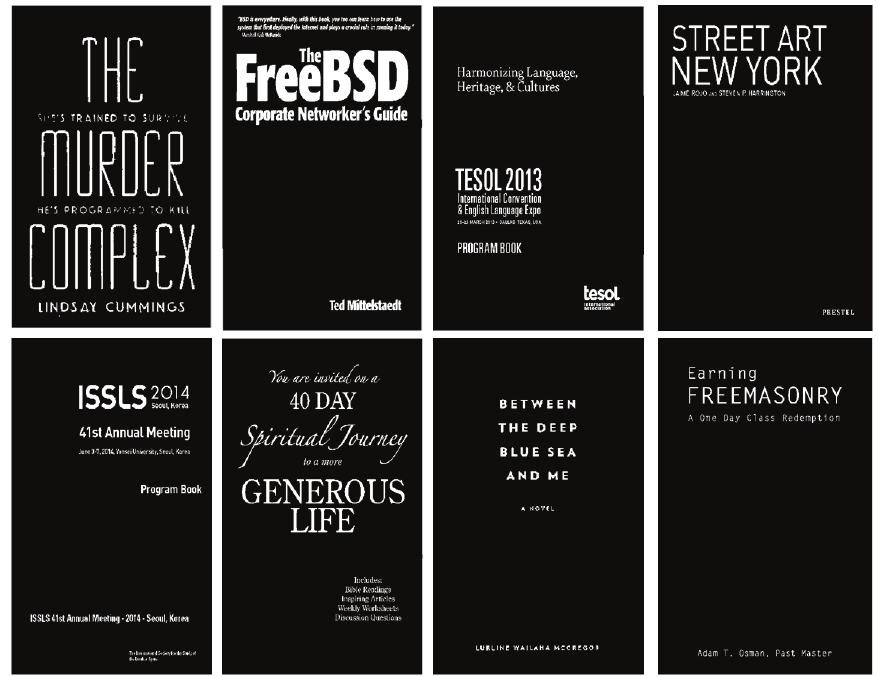
Figure 7: Final result of our system